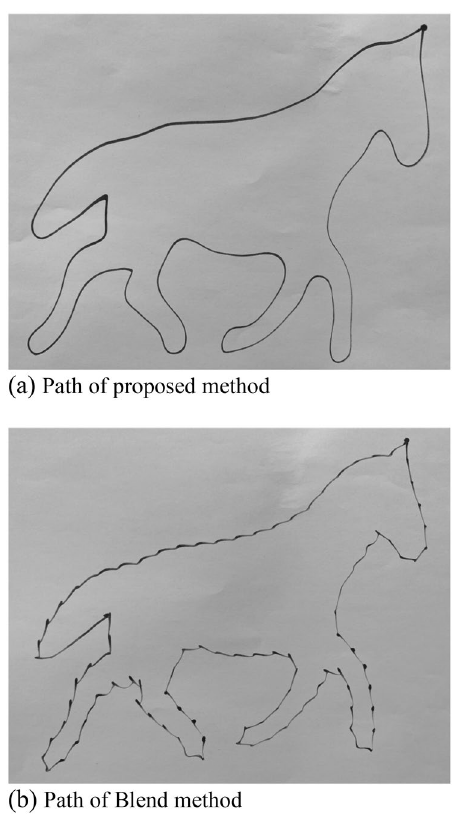
Figure 10 Comparison of paths of proposed and Blend method